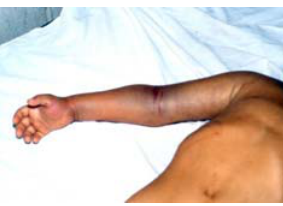
Figure 2: Crotalus durissus. The rattlesnakes were responsible for a number of injuries in the study area greater than that from the Ministry of Health for all the country.